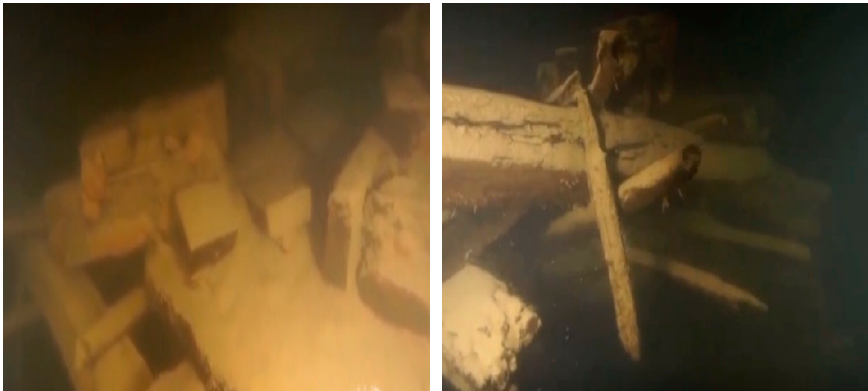
Figure 3. Damage of the underwater ancient town in Qiandao Lake.